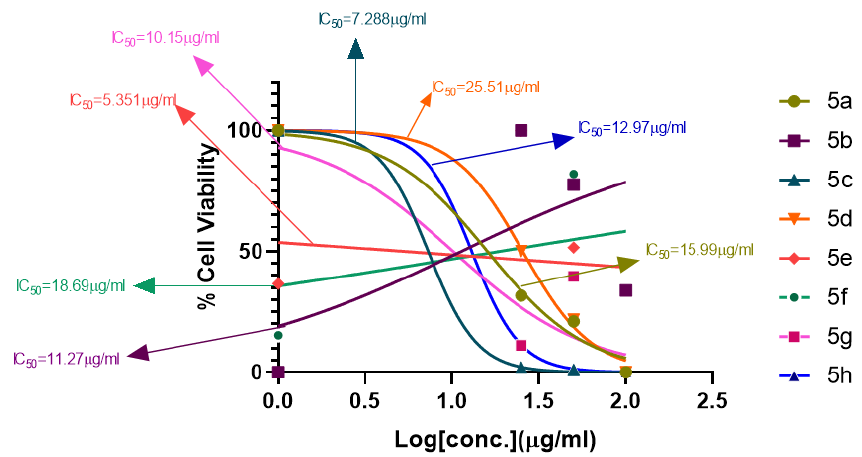
Figure 6. MTT cytotoxicity assay IC 50 values interpretation.